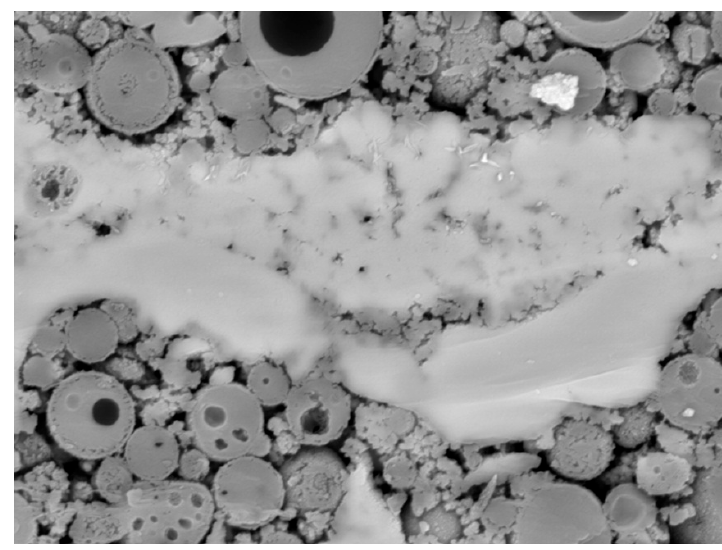
Figure 5. SEM image of region with fixed Cu, magnitude 7000×. Table 4. EDS analysis of the Cu cluster (atom %)